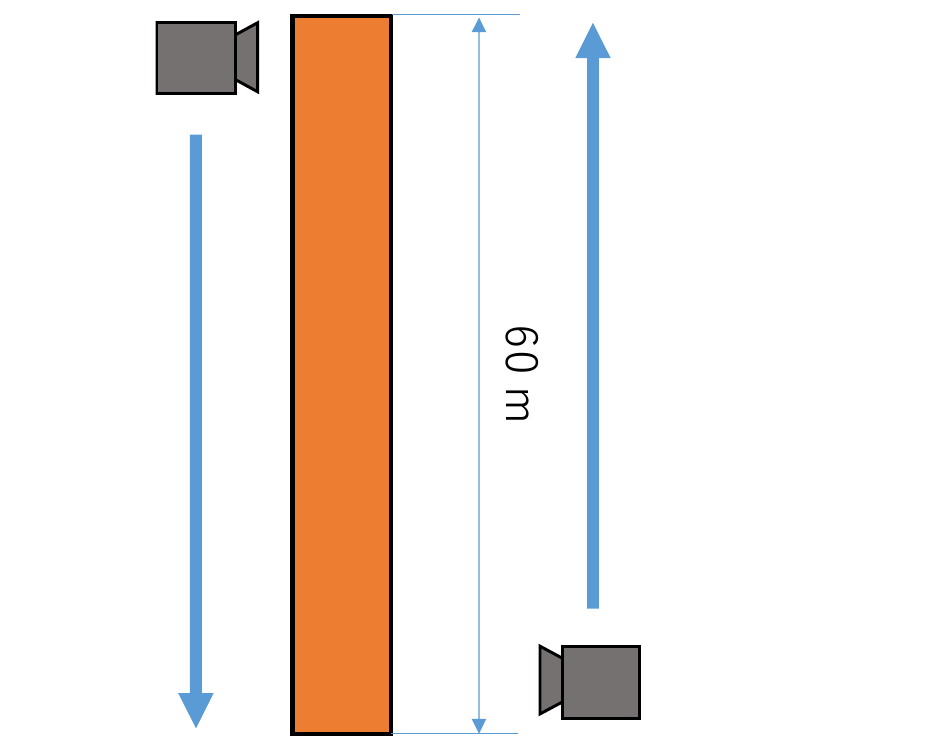
Figure 3. Photographic method used in the field.